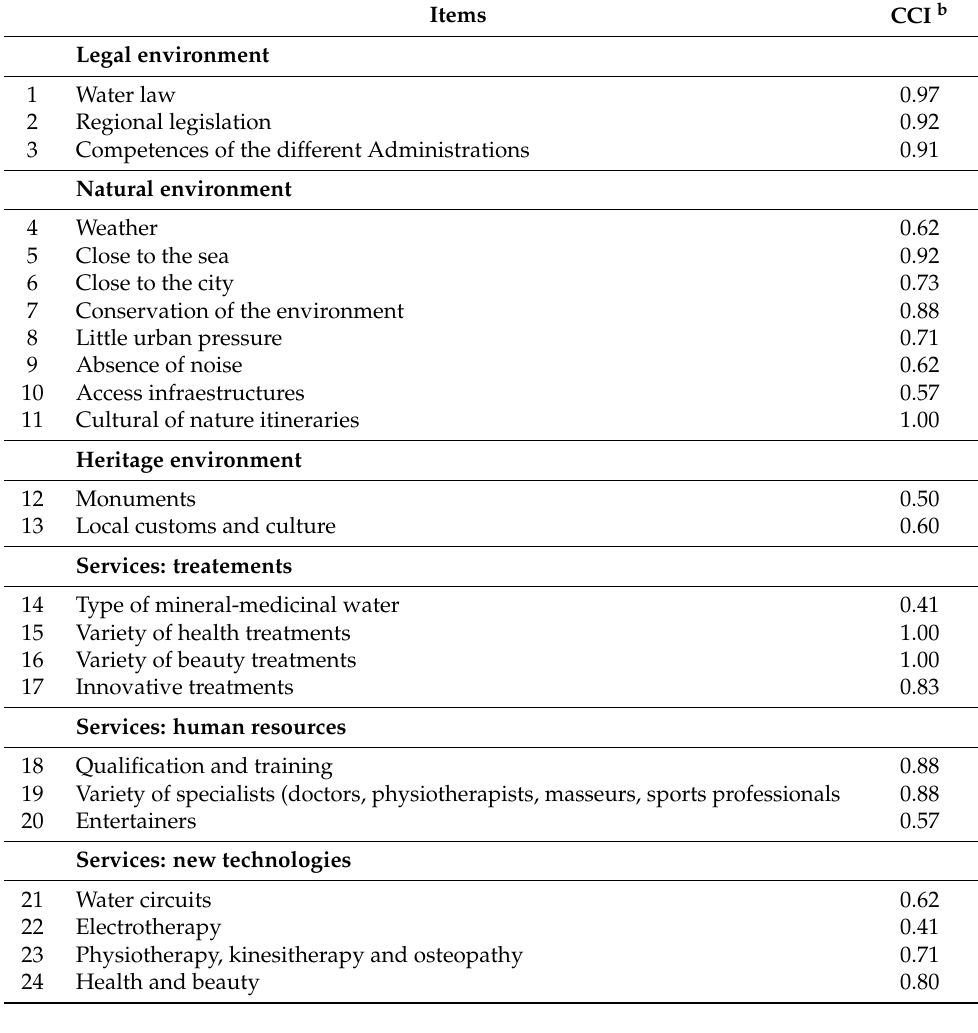
Table 1. Reliability of the 40 items of the Delphi questionnaire. Test-retest (one week apart) ( n = 6 a ).